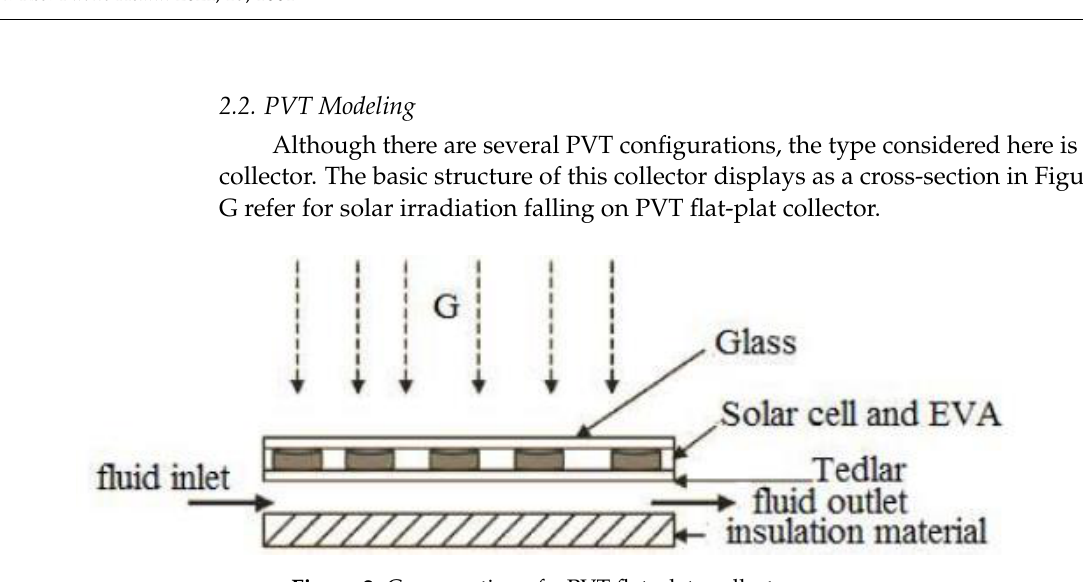
Figure 2. Cross-section of a PVT flat-plate collector.